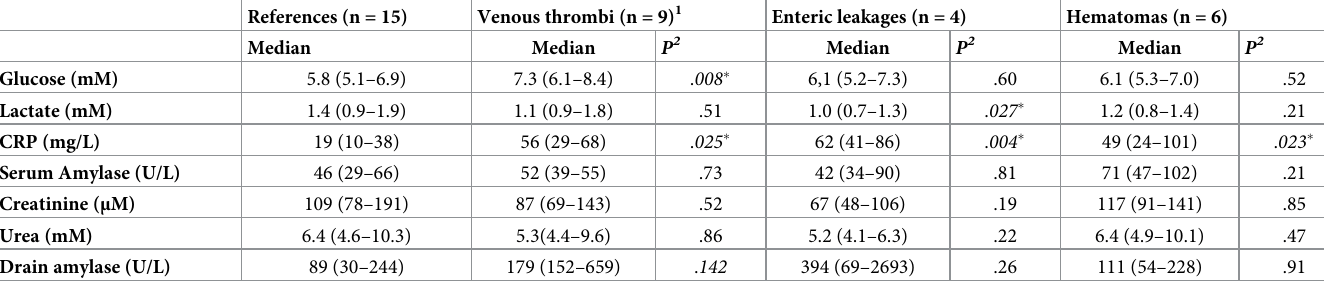
Table 2. Laboratory values from the entire observational period (median (quartiles)) in 34 consecutive pancreas